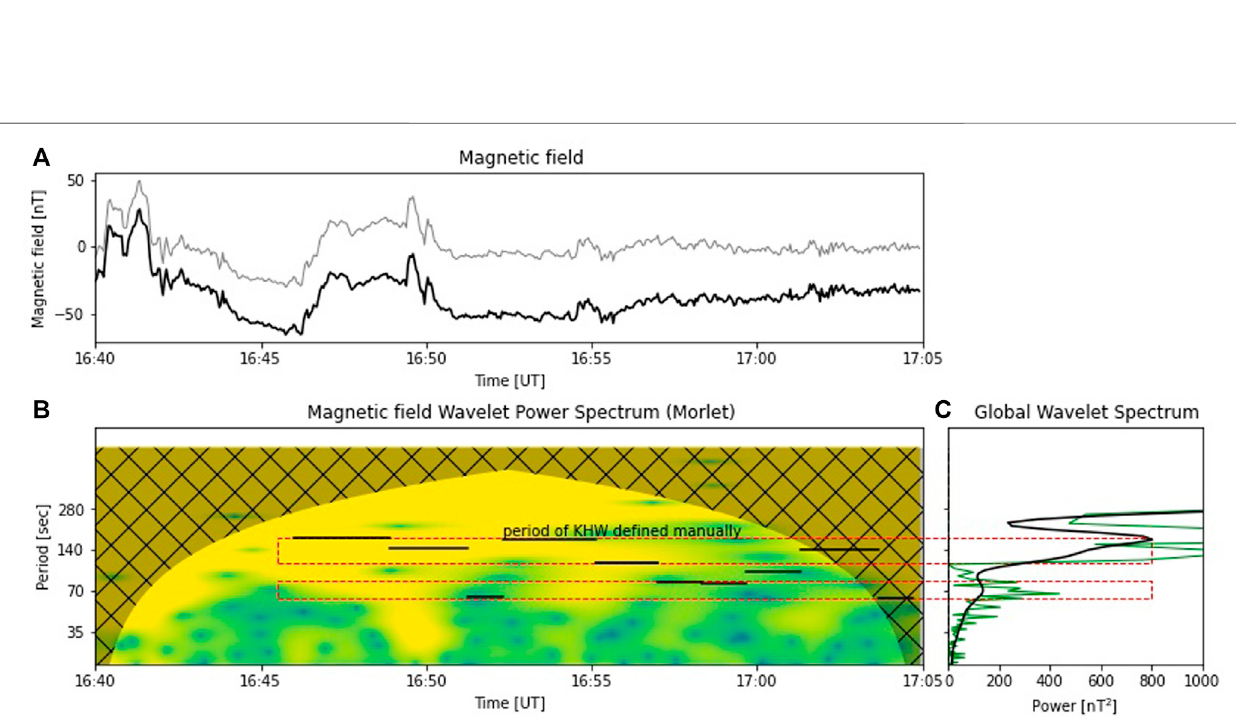
FIGURE 15 | Wavelet transform analysis of the magnetic fi eld oscillations for the Z GSE -component, nT, observed by THEMIS-E between 1640 and 1705 UT: (A) original (black) series and inverse (gray) wavelet transform; (B) the normalized wavelet power spectrum and shaded cone of in fl uence and (C) the global wavelet for periods outside of the COI (black) and Fourier power spectra (green). Note that the period scale is logarithmic. The horizontal lines in panel (b) indicate periods of KHW de fi ned manually in Figure 3 as the time between dashed lines for corresponding time intervals. The dashed red rectangles correspond to two period bands from 62 to 82 s and from 113 to 173